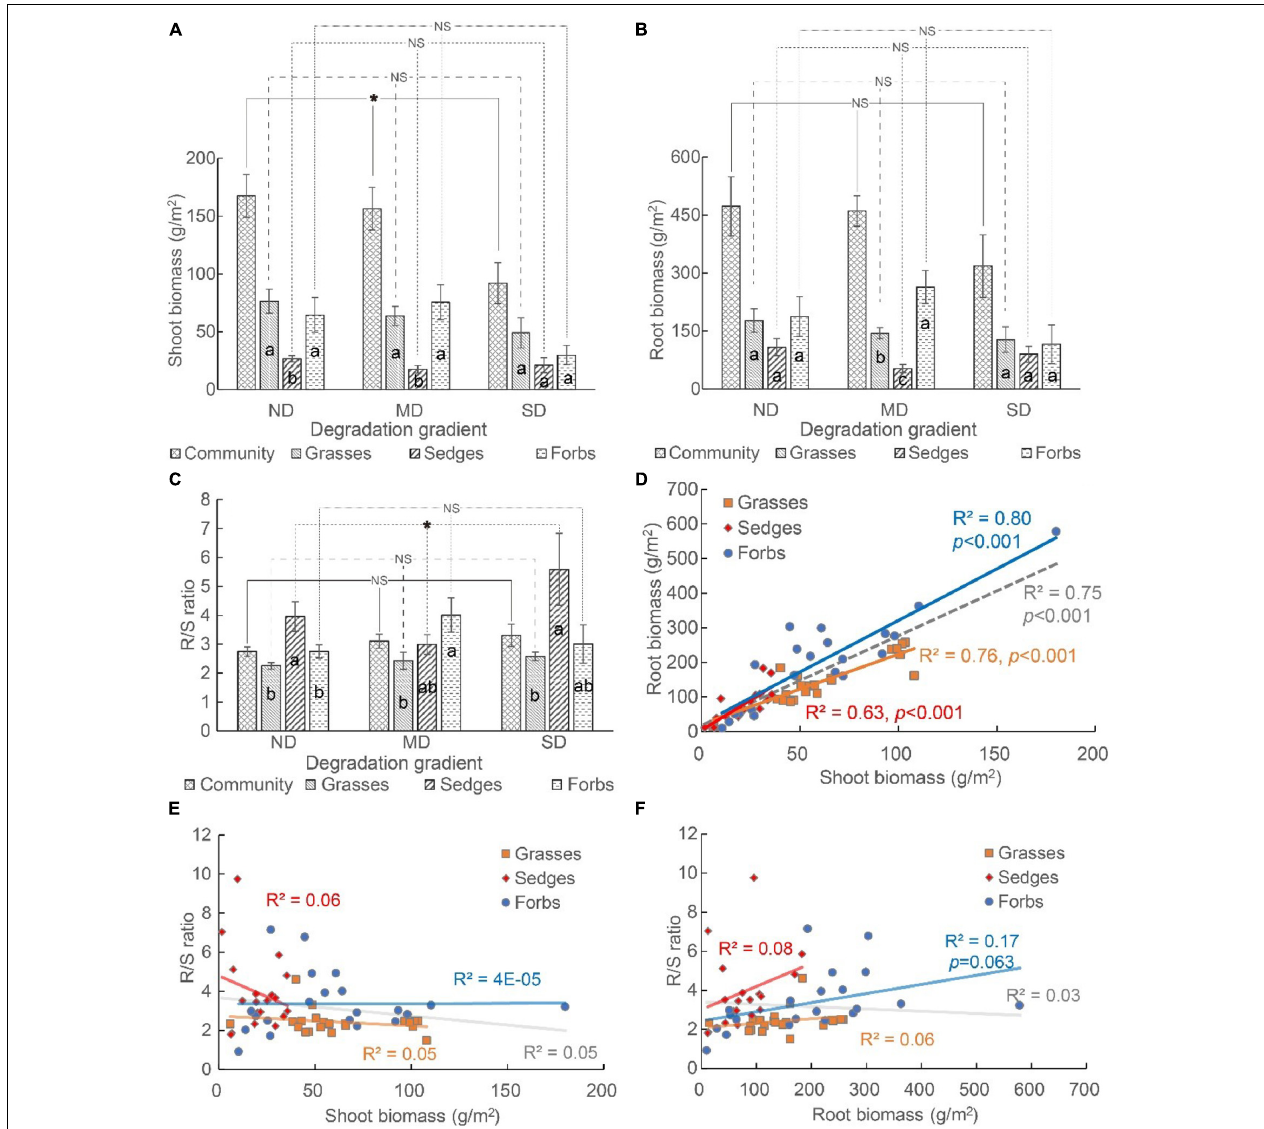
FIGURE 3 | The (A) shoot biomass, (B) root biomass, and (C) root-to-shoot ratio (i.e., R/S ratio) of plant community and different functional groups (i.e., grasses, sedges, and forbs), and (D–F) the relationship among shoot biomass, root biomass, and R/S ratio. The “*” means the significant difference among functional groups along the degradation gradient. NS means no differences were detected. The different lowercase letters mean significant differences among functional groups in each degradation